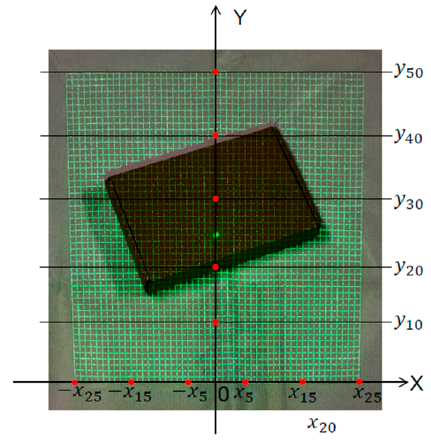
Figure 7. Obstacle area testing.